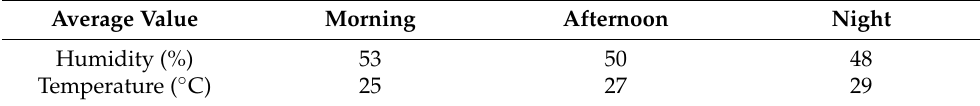
Table 6. Reported data from ambient